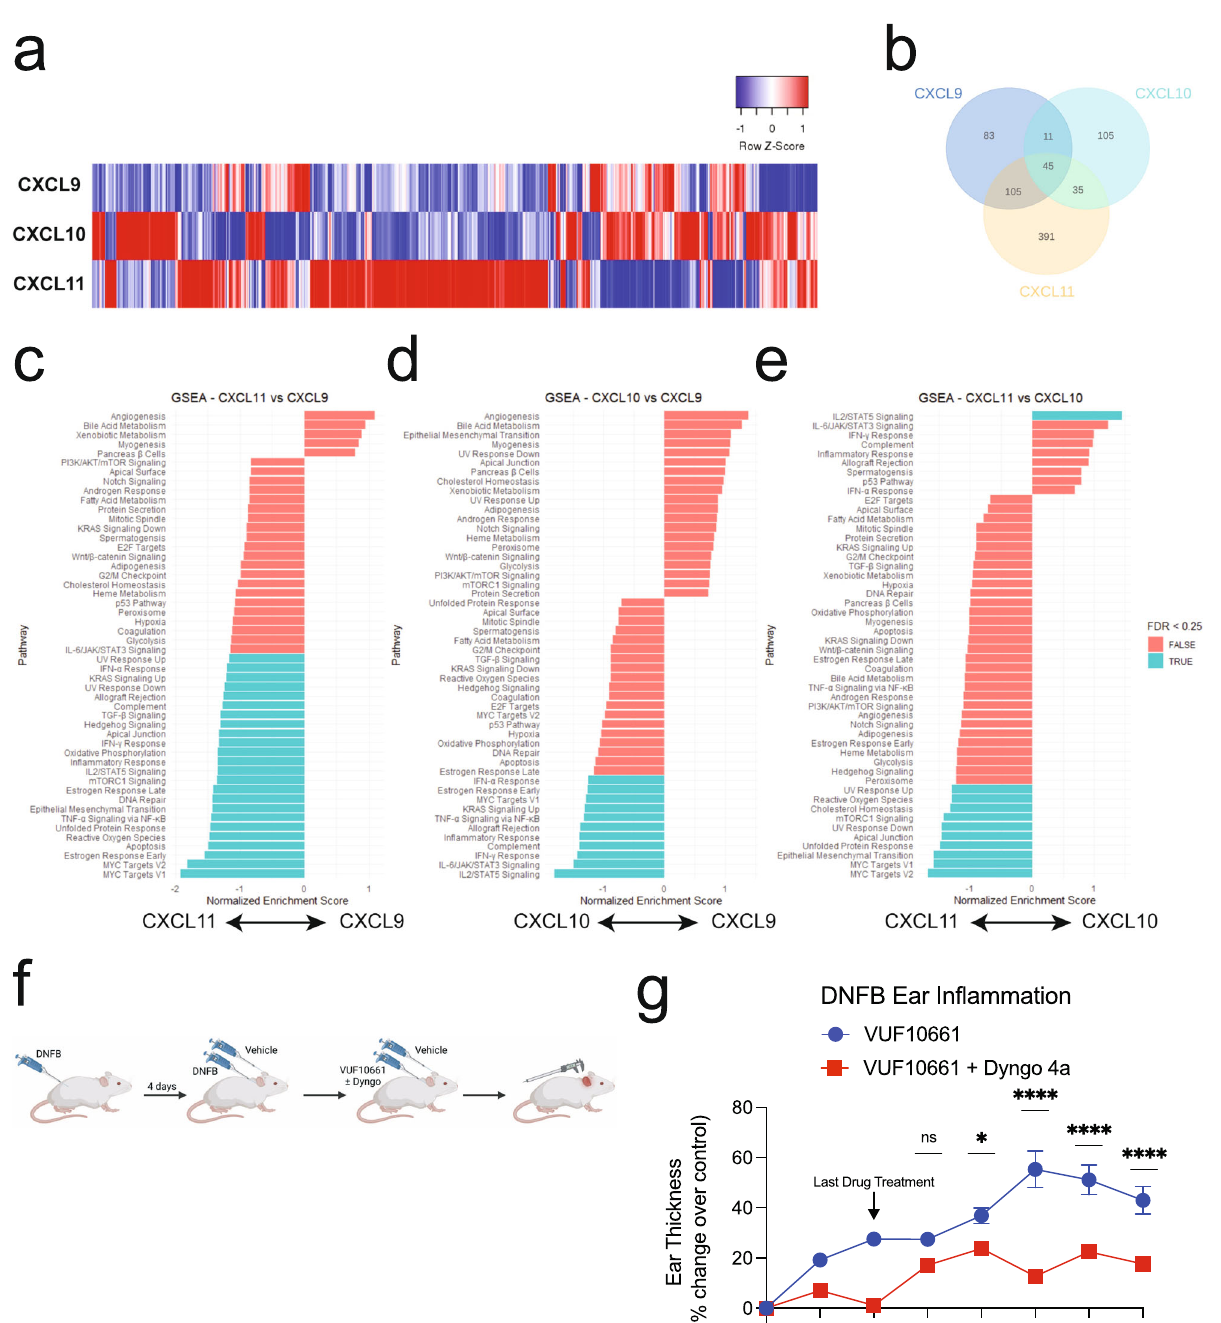
Fig. 6 | Receptor internalization is implicated in biased transcriptional reg- ulation in primary CD8+T cells and required for maximum CXCR3-mediated in fl ammation in mice. a Heat map of differentially expressed genes (DEGs) in primary CD8+T-cells treated with 100nM chemokine for 2h. b Venn diagram of DEGs compared to vehicle treatment. c – e Gene set enrichment analysis of differ- entially regulated pathways between chemokines. Listed pathways are statistically signi fi cant at P <0.05, however, select pathways are labeled as TRUE if the False DiscoveryRate(FDR)is<0.25andFALSEiftheFDRis>0.25.Statisticalmethodsfor Gene Set Enrichment Analysis (GSEA) are previously described 61 . See also Supple- mentary Fig. 5 for additional informatics analysis of CXCR3 transcriptomics. f Experimental design of the dinitro fl uorobenzene (DNFB)-induced contact hypersensitivity mouse model. Mice are sensitized with DNFB on their back,